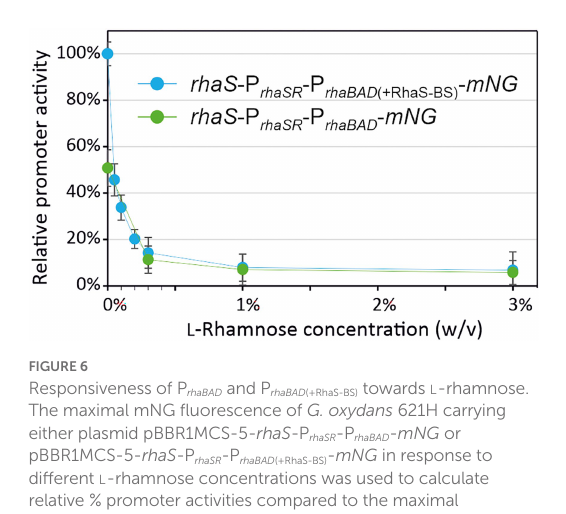
FIGURE 6 Responsiveness of P rhaBAD and P rhaBAD (+RhaS-BS) towards l -rhamnose. The maximal mNG fluorescence of G. oxydans 621H carrying either plasmid pBBR1MCS-5- rhaS -P rhaSR -P rhaBAD - mNG or pBBR1MCS-5- rhaS -P rhaSR -P rhaBAD (+RhaS-BS) - mNG in response to different l -rhamnose concentrations was used to calculate relative % promoter activities compared to the maximal P rhaBAD (+RhaS-BS) activity in the absence of l -rhamnose